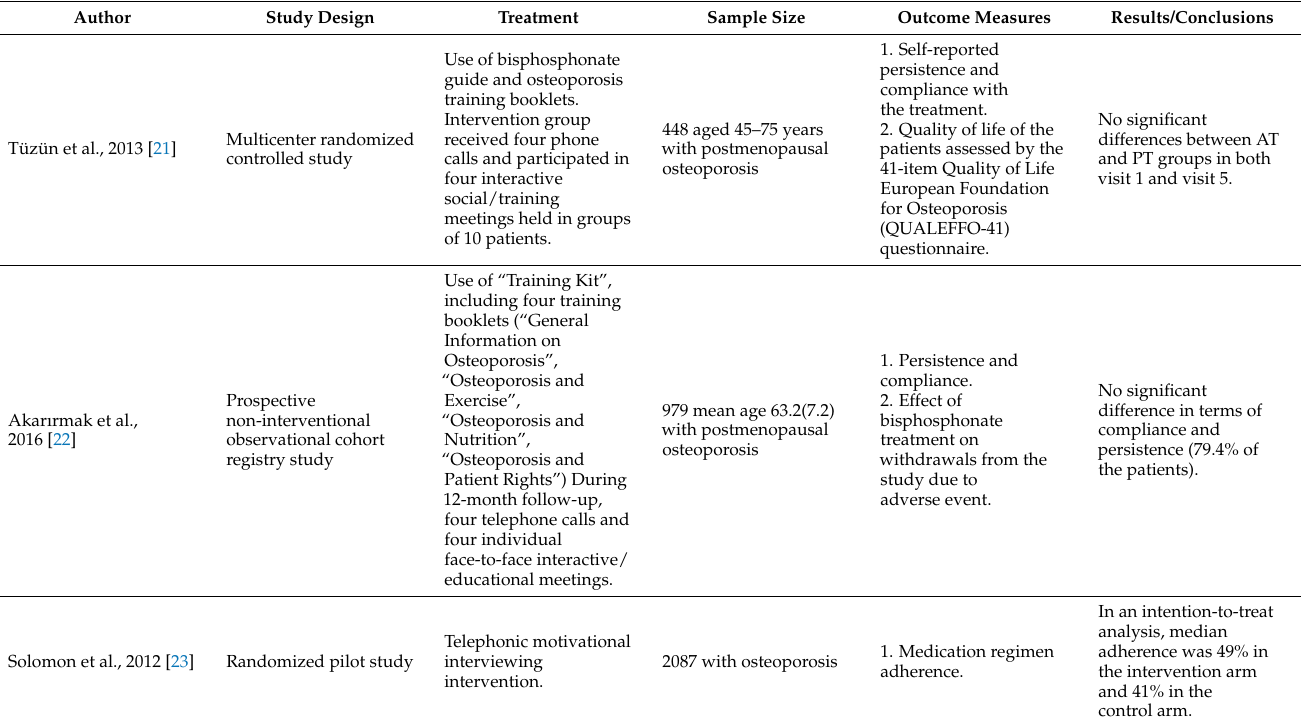
Table 2. Characteristics of studies analyzing methods and healthcare systems to enhance